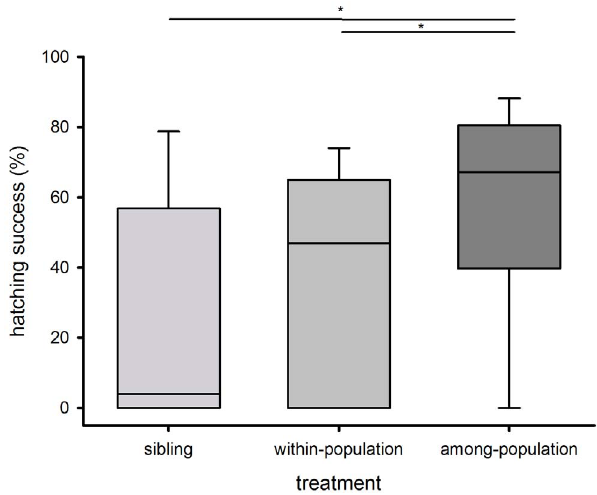
Figure 1. Hatching success (%) of the three mating treatments (sibling, within-population and among-population pairs). Hatching success was lowest for sibling matings (light grey), followed by within-population matings (grey) and was highest for among- population matings (dark grey). Box plots show the quartiles (box limits), the 10 th and 90 th percentiles (error bars) and the median (line). Statistically significant differences are indicated (*). doi:10.1371/journal.pone.0095963.g001 x 2 = 0.65, p = 0.89, N= 64). The observed heterozygosity of the four populations ranged from 0.31 to 0.38 and was much lower than the expected heterozygosity (range from 0.59 to 0.62; Table 2). Furthermore, the nucleotide diversity (range from 0.0008 to 0.0015) as well as the haplotype diversity (range from 0.61 to 0.71) of the four populations calculated by the mitochondrial COI data set showed similar genetic diversities within the four populations (Table 2). The number of haplotypes of the four populations ranged from 4 to 6 (Table 2). The overall F ST value showed a moderate, but significant differentiation (0.052; p = 0.0001) and differentiation between all population pairs were significant (Table 3).